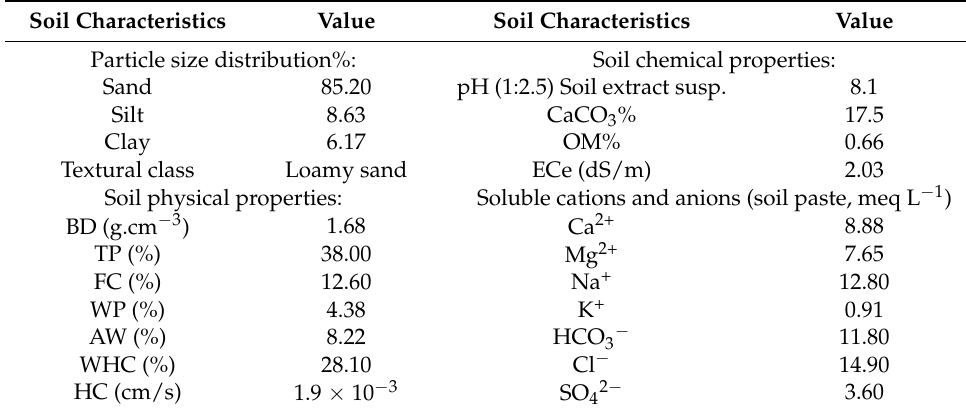
Figure 1. Location satellite image. Table 1. Some of the investigated soil’s physical and chemical